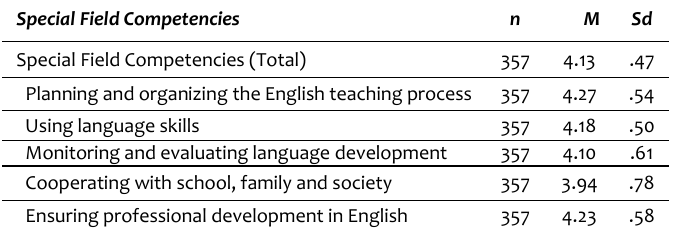
Table 1. Descriptive statistics for preservice English teachers' special field competencies Special Field Competencies n